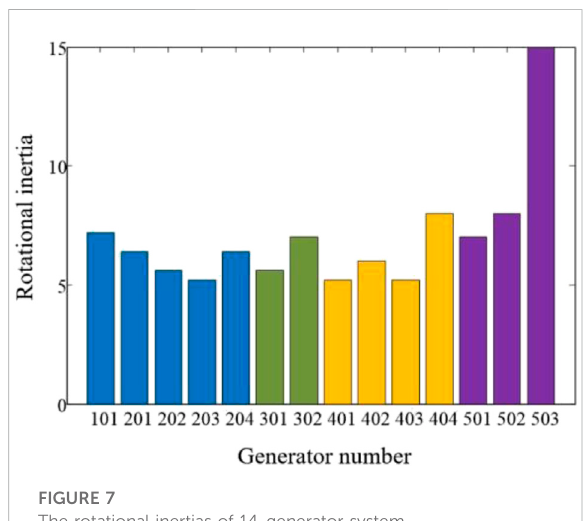
FIGURE 7 The rotational inertias of 14-generator system.